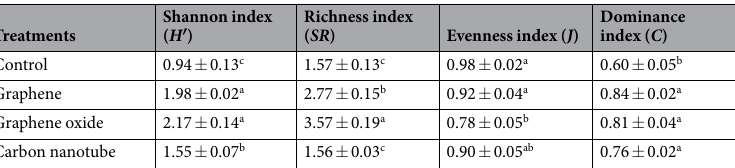
Table 2. Diversity indices of the soil microarthropod community under the different treatments. Different letters within the same column indicate statistically significant differences between treatments, according to the LSD multiple range test ( p <